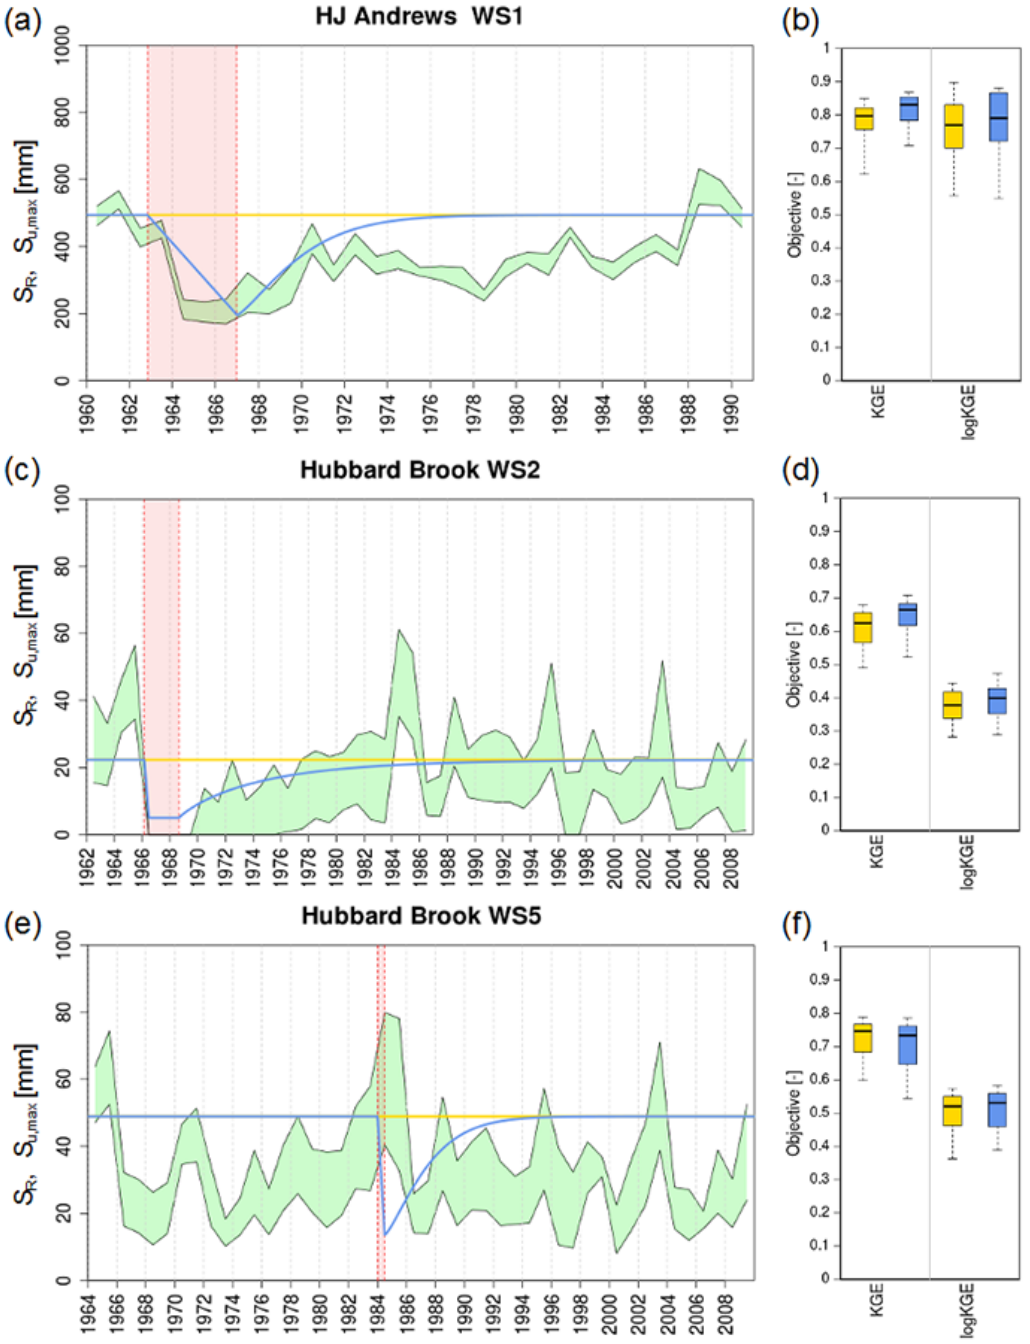
Figure 8. The time invariant S u, max formulation represented by S R,20yr (yellow) and time dynamic S u, max fitted Weibull growth function (blue) with a linear reduction during deforestation (red shaded area) and mean 20-year return period root-zone storage capacity S R, 20yr as equilibrium value for (a) HJ Andrews WS1 with a = 0.0001days − 1 , b = 1.3 and S R,20yr = 494mm with (b) the objective function values, (c) Hubbard Brook WS2 with a = 0.001 days − 1 , b = 0.9 and S R,20yr = 22mm with (d) the objective function values, and (e) Hubbard Brook WS5 with a = 0.001 days − 1 , b = 0.9 and S R,20yr = 49mm and with (f) the objective function values. The green shaded area represents the maximum and minimum boundaries of S R,1yr from the water balance-based estimation, caused by the sampling of interception capacities.